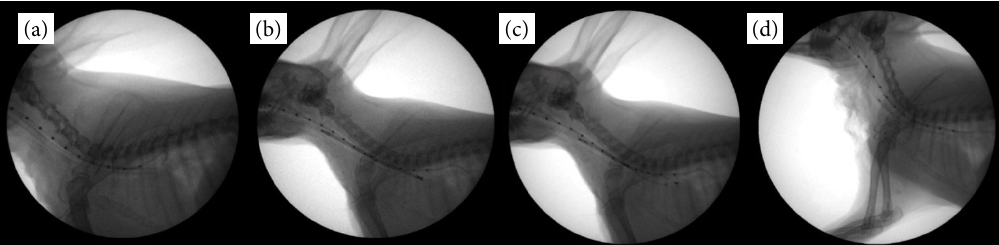
Figure 4 - Fluoroscopic images of step-by-step stenting procedures. (a) A 5-Fr radiopaque marker catheter was inserted into the esophagus under fluoroscopic guidance. (b) Each delivery system was passed through the endotracheal tube, and the starting point of the stent was visualized using fluoroscopy. (c) The self-expanding metal stent was deployed slowly to ensure that the stent was positioned accurately. (d) Each stent was fully deployed, and the delivery system was carefully removed from the